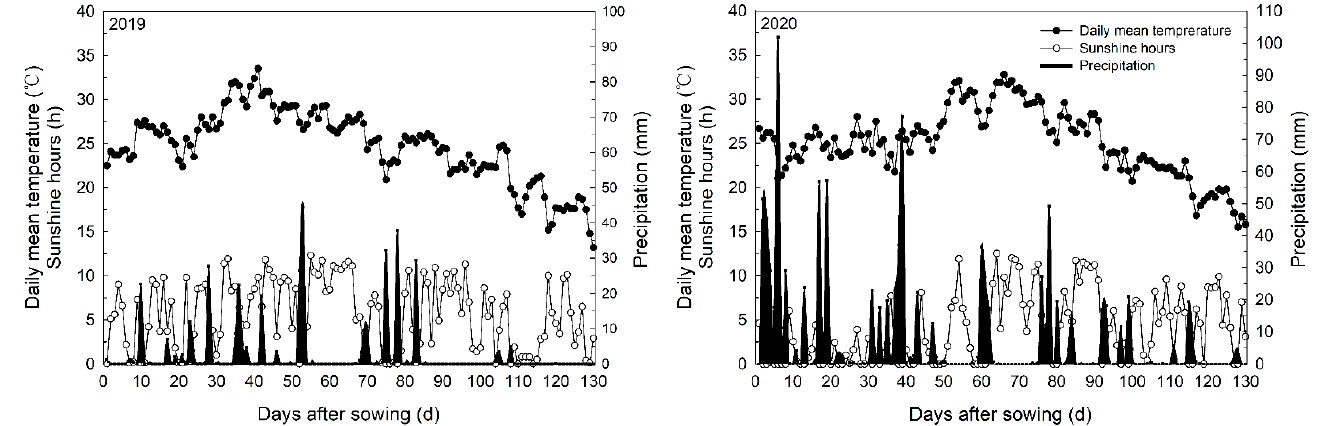
Figure 1. Daily mean temperature, sunshine hours, and precipitation during the rice growth season in 2019 and 2020.